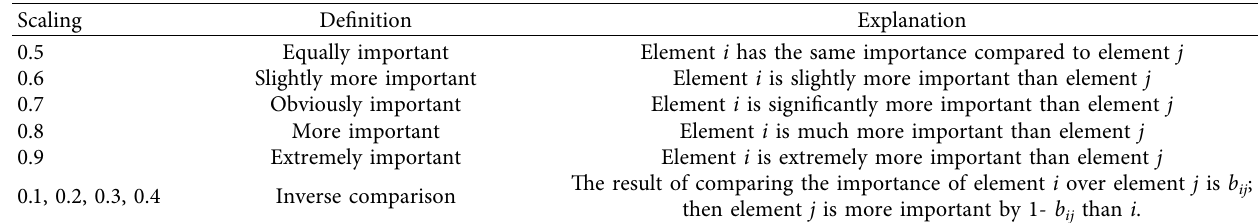
Table 5: Scale values of